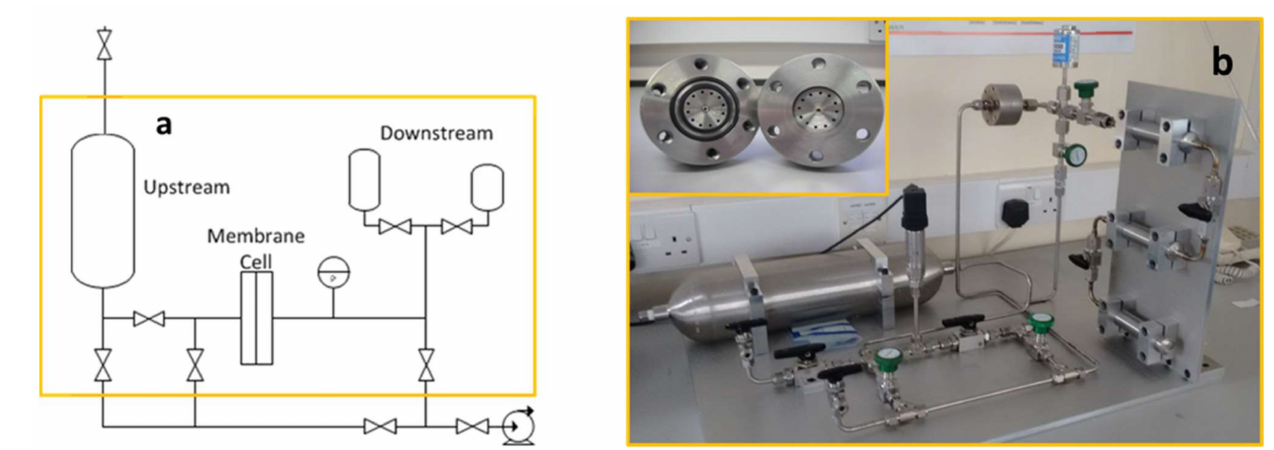
Figure 2. Permeation rig: ( a ) schematic; ( b ) rig with the